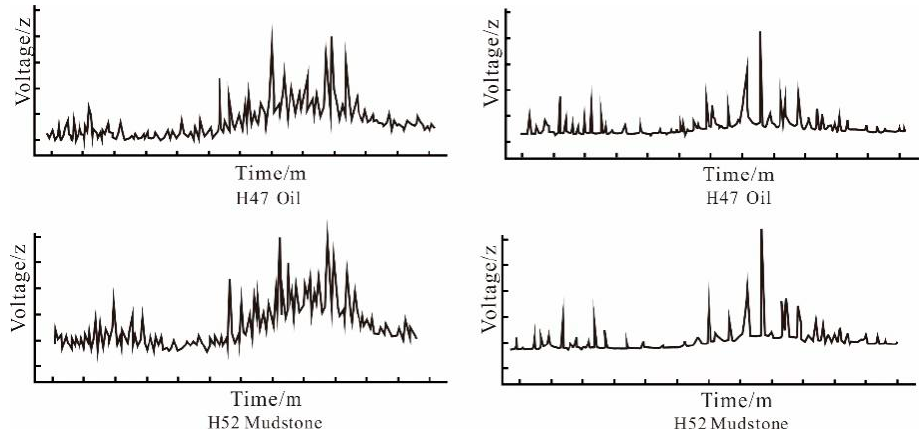
Figure 7. The m / z 217 and m / z 191 fingerprints between crude oil and mudstone in the Figure 7. The m/z 217 and m/z 191 fingerprints between crude oil and mudstone in the Qingshankou Qingshankou Formation.